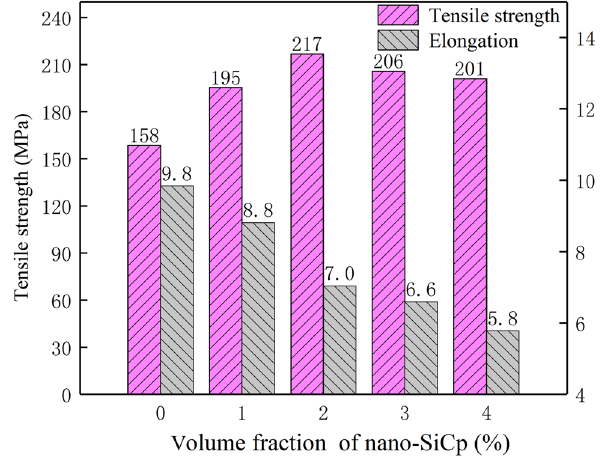
Figure 6: Tensile properties of nanocomposites with di ff erent SiCp volume